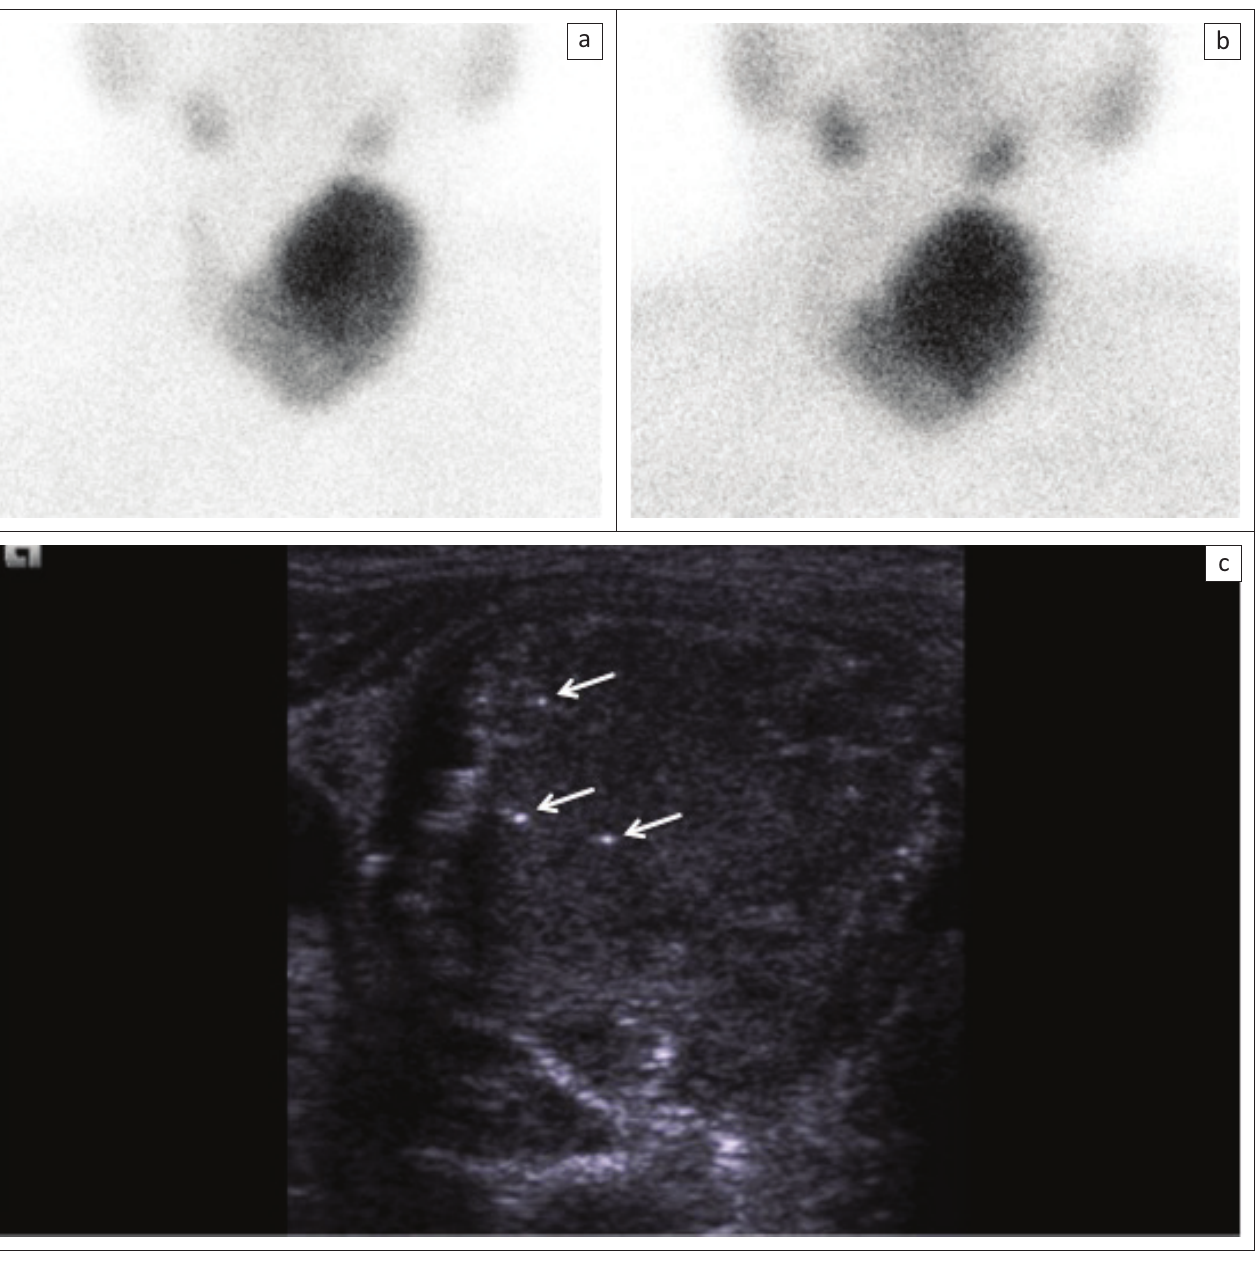
FIGURE 2: 99mTc-MIBI scintigraphy and ultrasonography of the thyroid of a 65-year-old woman with left thyroid nodule. There is intense 99mTc-MIBI uptake on both early (a) and delayed (b) images in the left lobe of the thyroid. Ultrasonography (c) showed multiple microcalcifications (arrows). The features on the two studies are suggestive of malignancy. Histology confirmed a papillary